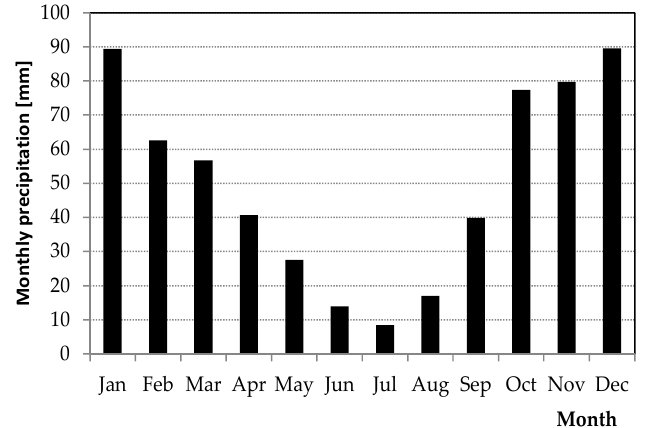
Figure 2. Monthly precipitation pattern. Lipari meteo-station (averages in the period 1920–1994).